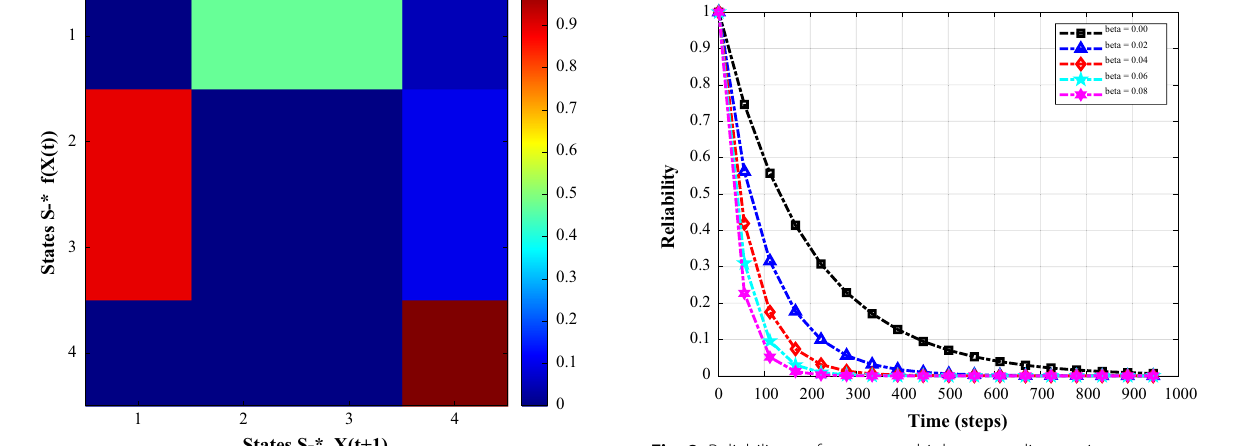
Fig. 8 Reliability performance at high system diagnostic coverage level and 95% repair